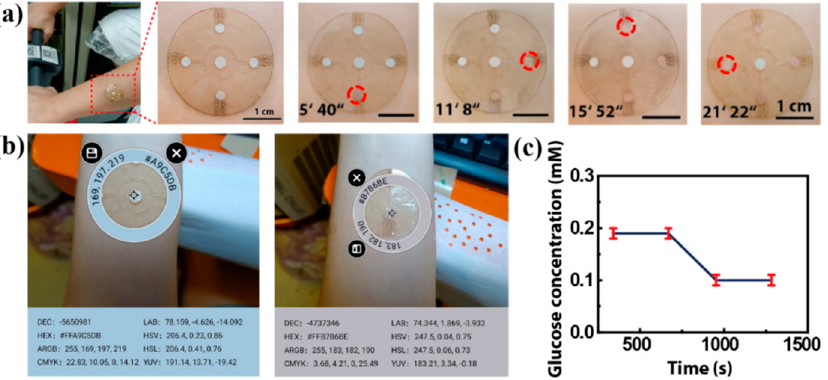
Figure 9. The on-body experiments: ( a ) microfluidics patch attached to the forearm of a volunteer. The time of sweat flowing into each microreservoir is shown, and the sweat makes the color marker allochroic. ( b ) A physical picture of the microfluidic patch on a volunteer’s forearm. The RGB values of the standard color card and the colored color markers are obtained with a color picker. ( c ) The glucose concentration in the volunteer’s sweat, referring to the fitting line in Figure 8e.